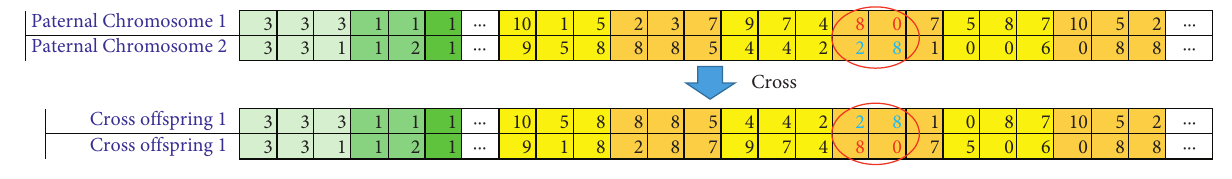
Figure 6: Crossover structure. Table 2: Constant variables in the calculation example.